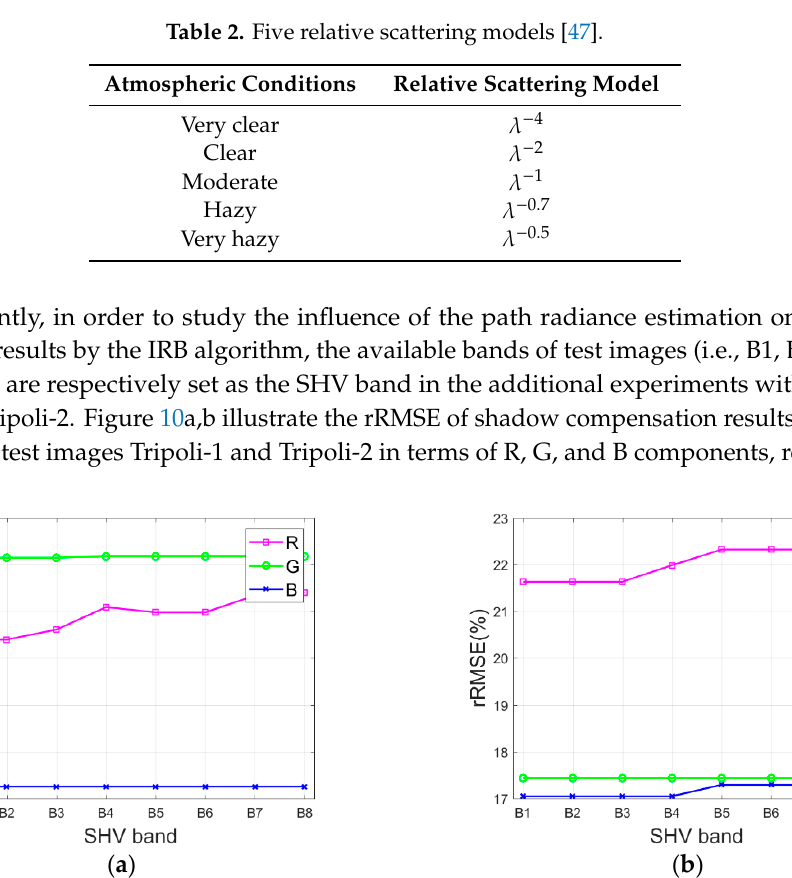
( b ) Figure 11. rRMSE of shadow compensation results with various p values for test images. ( a ) Tripoli-1. ( b ) Tripoli-2. As can be observed in Figure 11a,b, obviously, relatively lower rRMSE values are acquired for R, G, and B components with p value of 4, 5, 6, or 7 for test images Tripoli-1 and Tripoli-2. Additionally, the rRMSE curves in Figure 11a,b show an increasing trend for test images Tripoli-1 and Triploli-2 with the p value from 1 to 30. Consequently, in this study, we handle test images with parameter p value of 5.